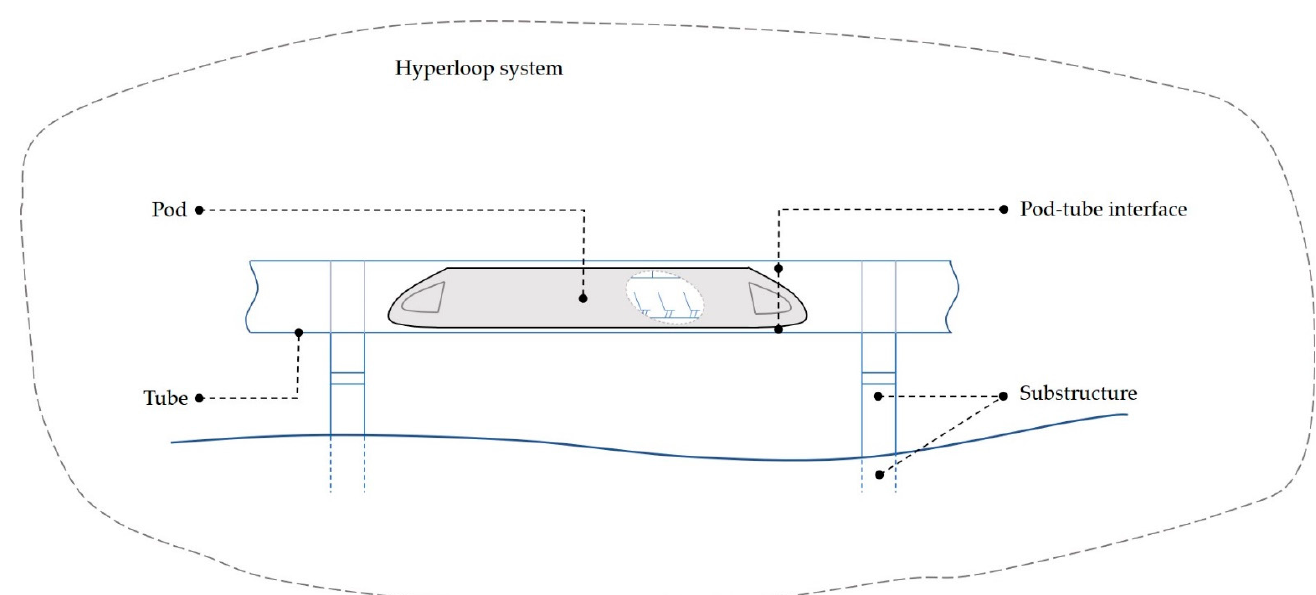
Figure 2. Hyperloop system decomposition (adapted from [14]).